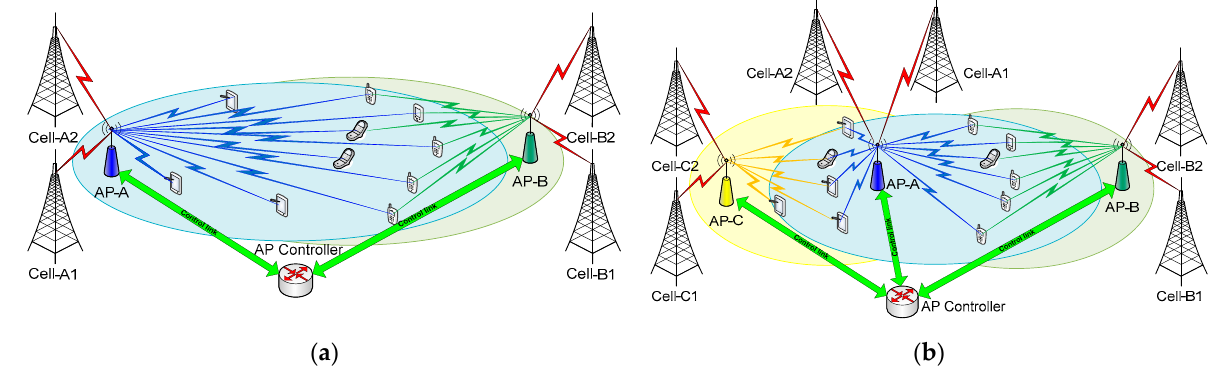
Figure 4. Networking scenario with several APs deployment: ( a ) 2 AP deployment; ( b ) 3 AP de-